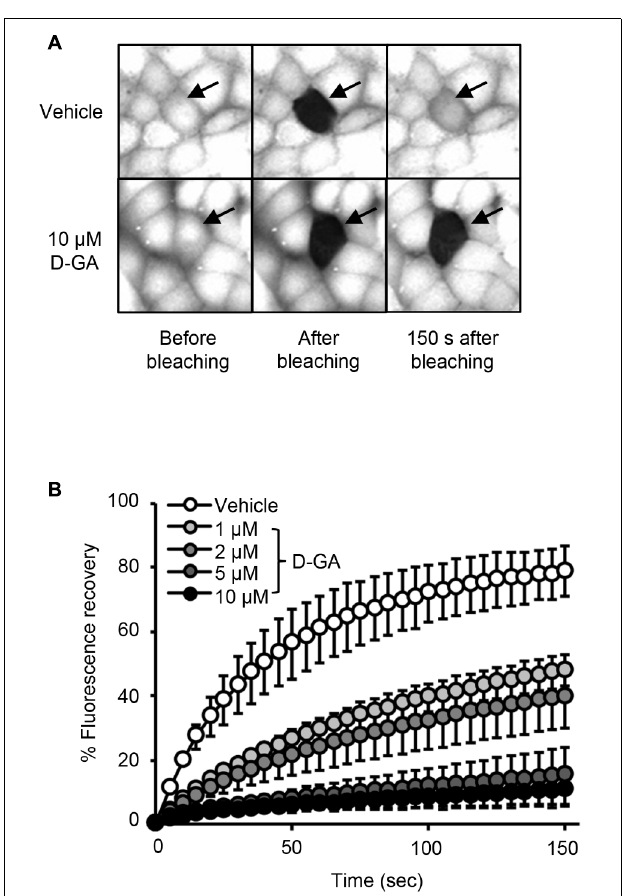
FIGURE 3 | Inhibition of GJIC by D-GA as demonstrated by the Gap-FRAP assay. FRT-Cx43 cells pre-loaded with calcein-AM were treated with vehicle, 1, 2, 5, or 10 µ M D-GA before the FRAP assay. Representative images of the gap-FRAP assay are presented in (A) . The percentage of fluorescence recovery was plotted as the mean ± SD ( n = 10) against incubation time after photobleaching (B) .